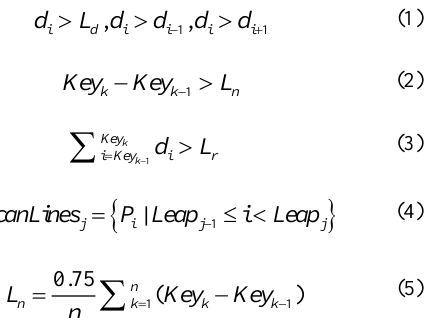
Figure 2. (a) Geometric features of scan line, and(b) example of extracted road